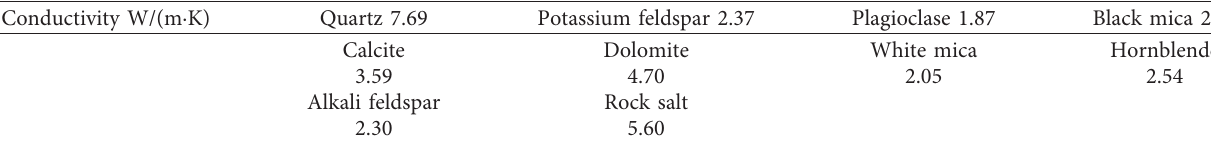
Figure 2: (a) Random mineral composition model vs. (b) single mineral composition model. Table 1: Thermal conductivity of different mineral compositions.